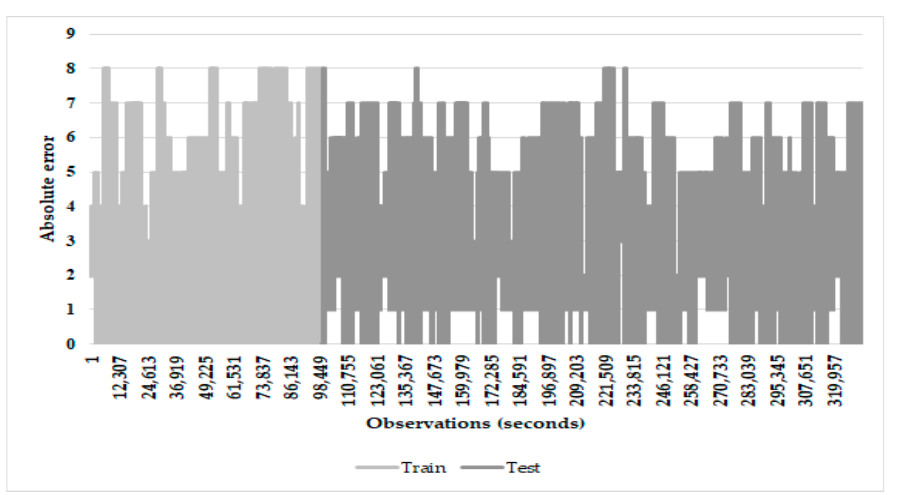
Figure 1. Absolute error versus observations in seconds for the logistic regression model with a 30%/70% training/testing split. Table 5. Forecasting efficacy of the random forest model for different training and testing partitions.